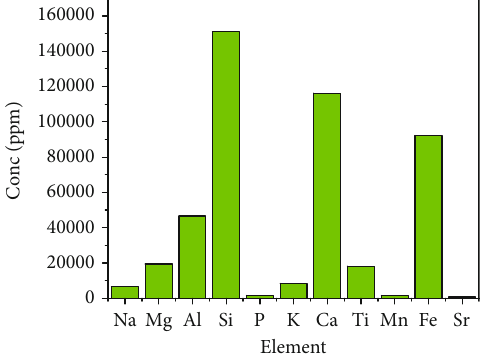
Figure 4: Elemental composition of red rock material calcined at a temperature of 1000 °